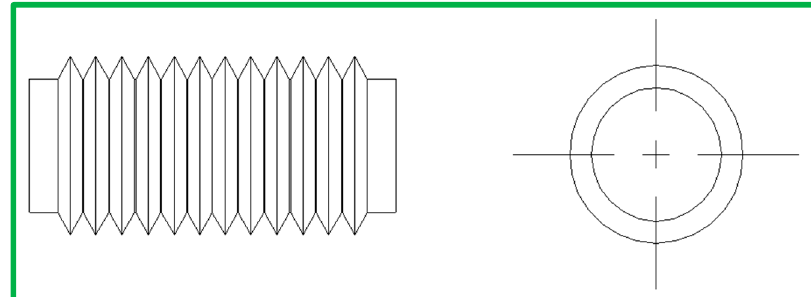
Figure 5. Schematic of the thread matrix rod.